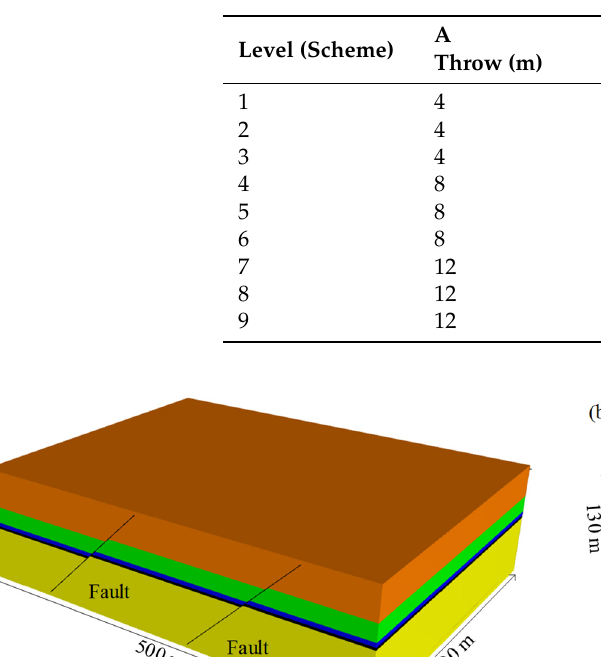
Table 4. Orthogonal test schemes of four factors and three levels (3 4 ).